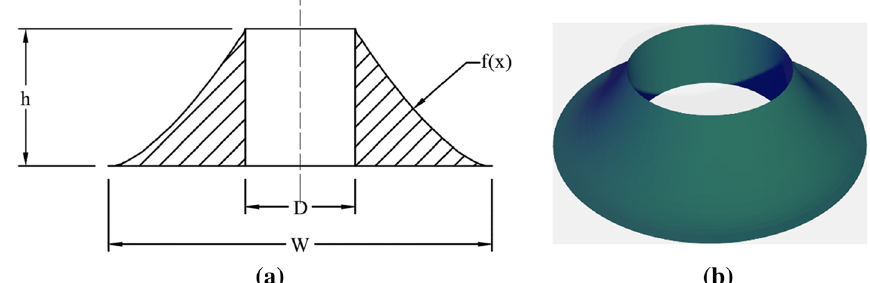
Fig. 1 Schematic diagram of horn-shaped collar. a The cross-section view and shape parameters of the horn-shaped collar ( D is the pier diameter). b Three-dimensional model of the horn-shaped